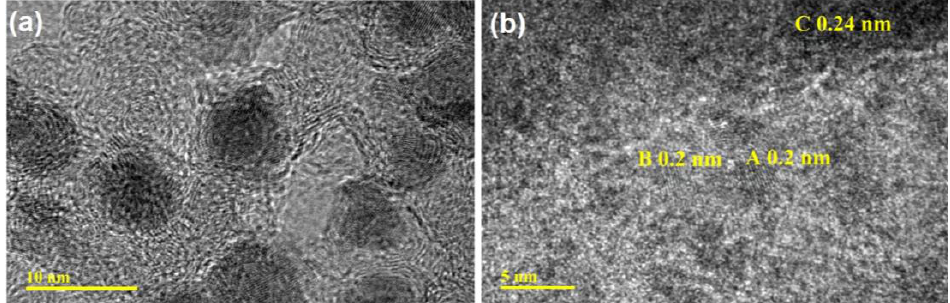
Figure 4. TEM of CoNi@C. ( a ) 10 nm and ( b ) 5 nm.